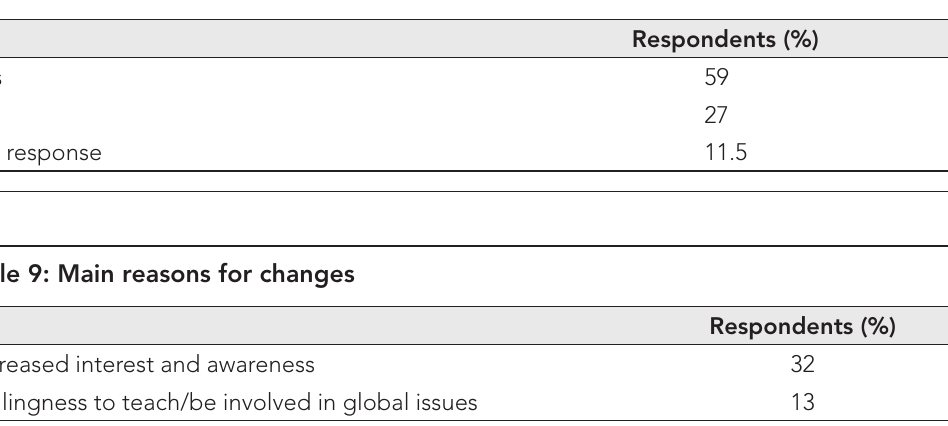
Table 8: Have your views changed during the semester?